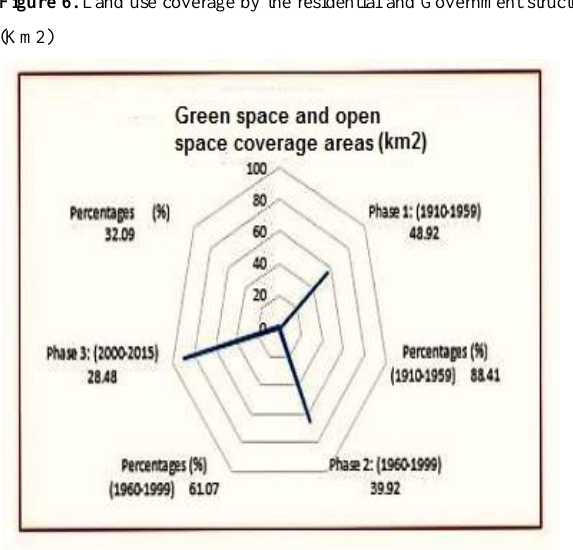
Figure 7. Land use coverage by the green space and open space areas